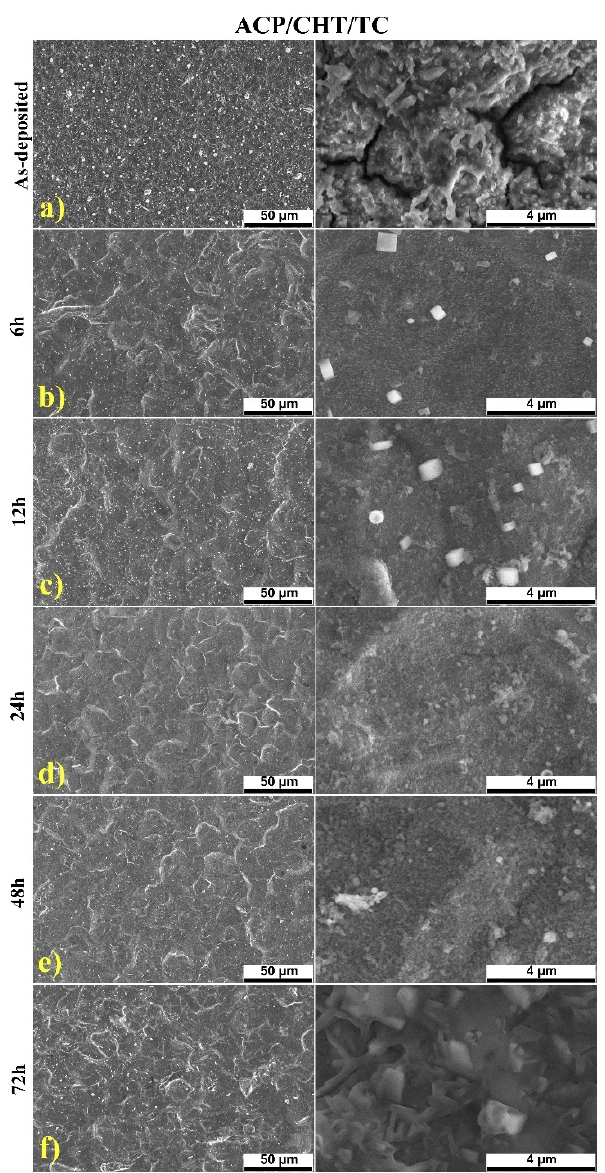
Figure 3. Typical SEM micrographs of: as-deposited ACP/CHT/TC coating ( a ), and after 6 ( b ), 12 ( c ), 24 ( d ), 48 ( e ), and 72 ( f ) hours degradation in SBF (left column 50 μm magnification and right column 4 μm magnification).